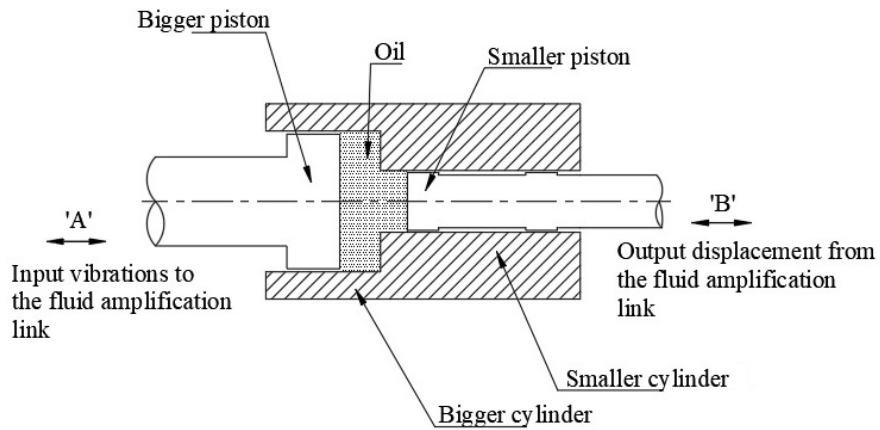
Figure 4. Fluid amplification link details.